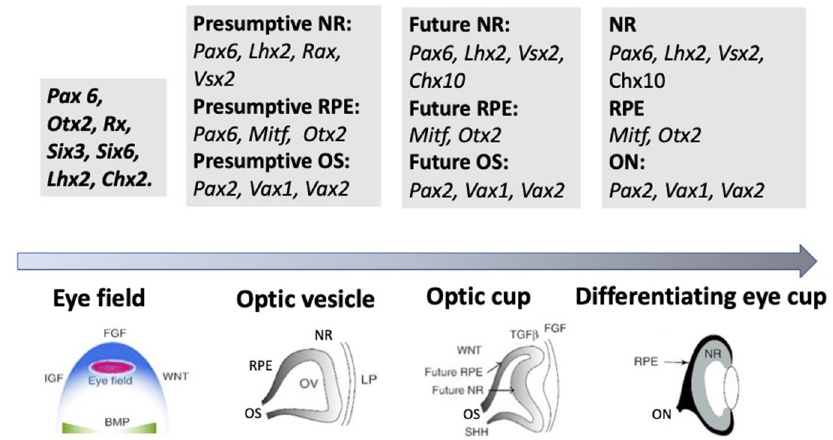
Figure 4. A schematic illustration of the groups of key transcription factors whose expression is associated with the main successive stages of eye development. NR—neural retina, RPE—retinal pigmented epithelium, OS—optic stalk, ON—optic nerve. See the detailed description is in the text.